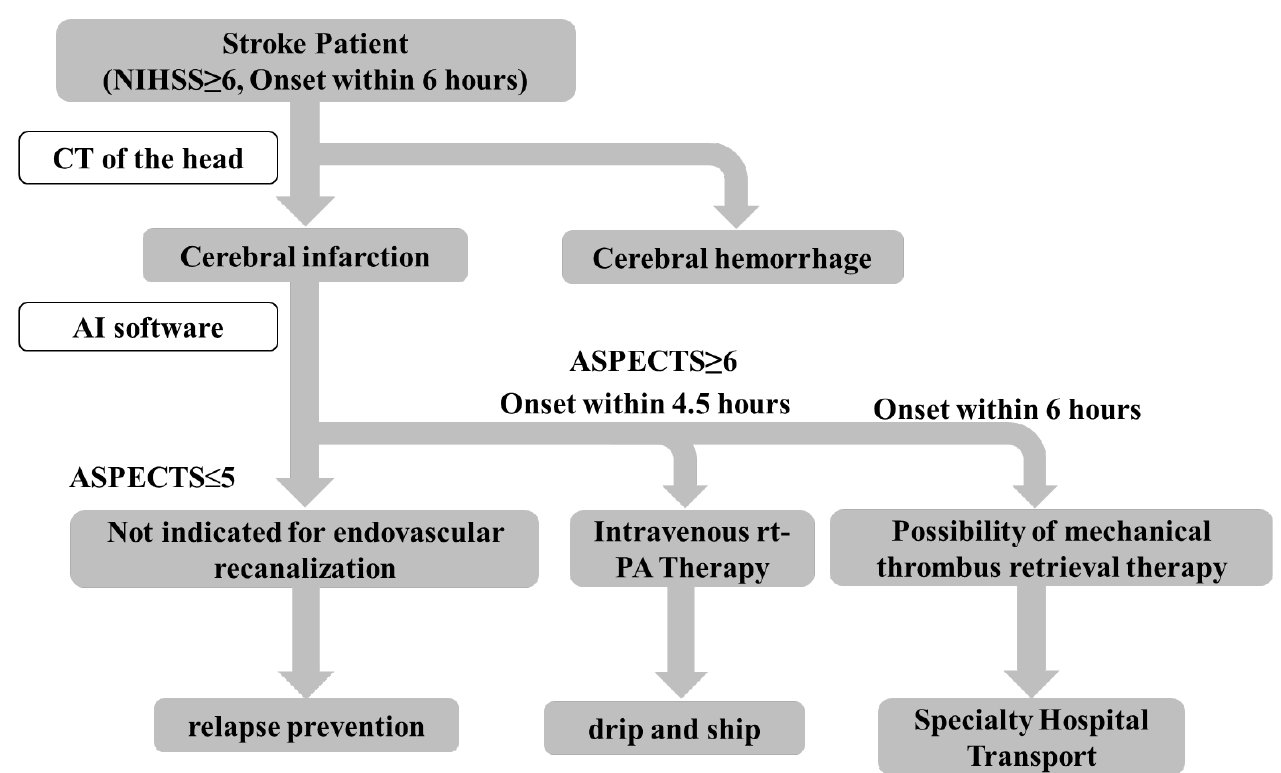
Figure 5. Possible diagnostic algorithm of stroke utilizing the AI software.